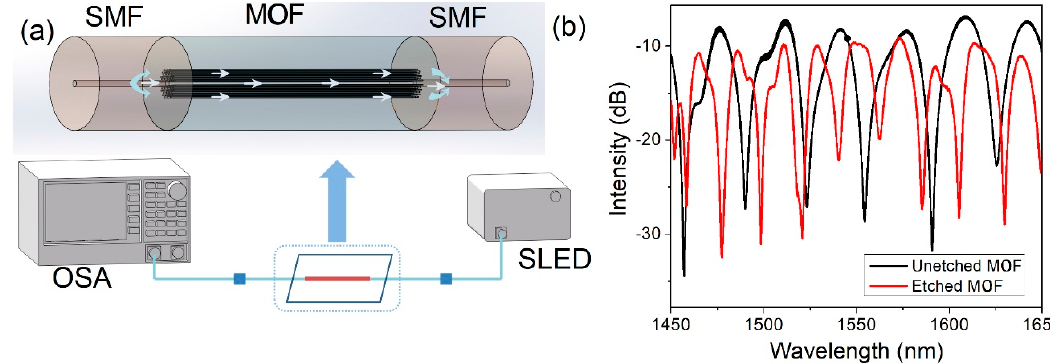
Figure 2. ( a ) Schematic of the experiment; ( b ) The transmission spectrum of unetched MOF and etched